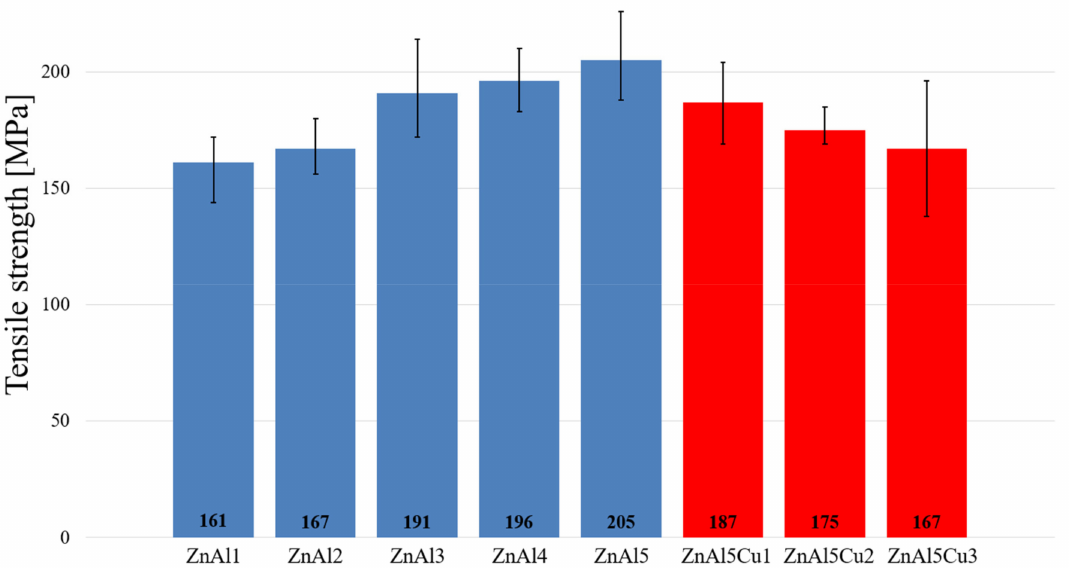
Figure 11. Tensile strength of type Zn–Al–Cu soldering alloys in dependence on Al and Cu